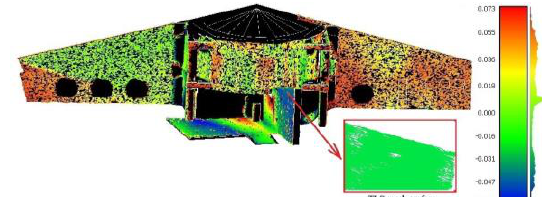
Figure 12. The Hausdorff distances calculated for the sample points generated for the front facade